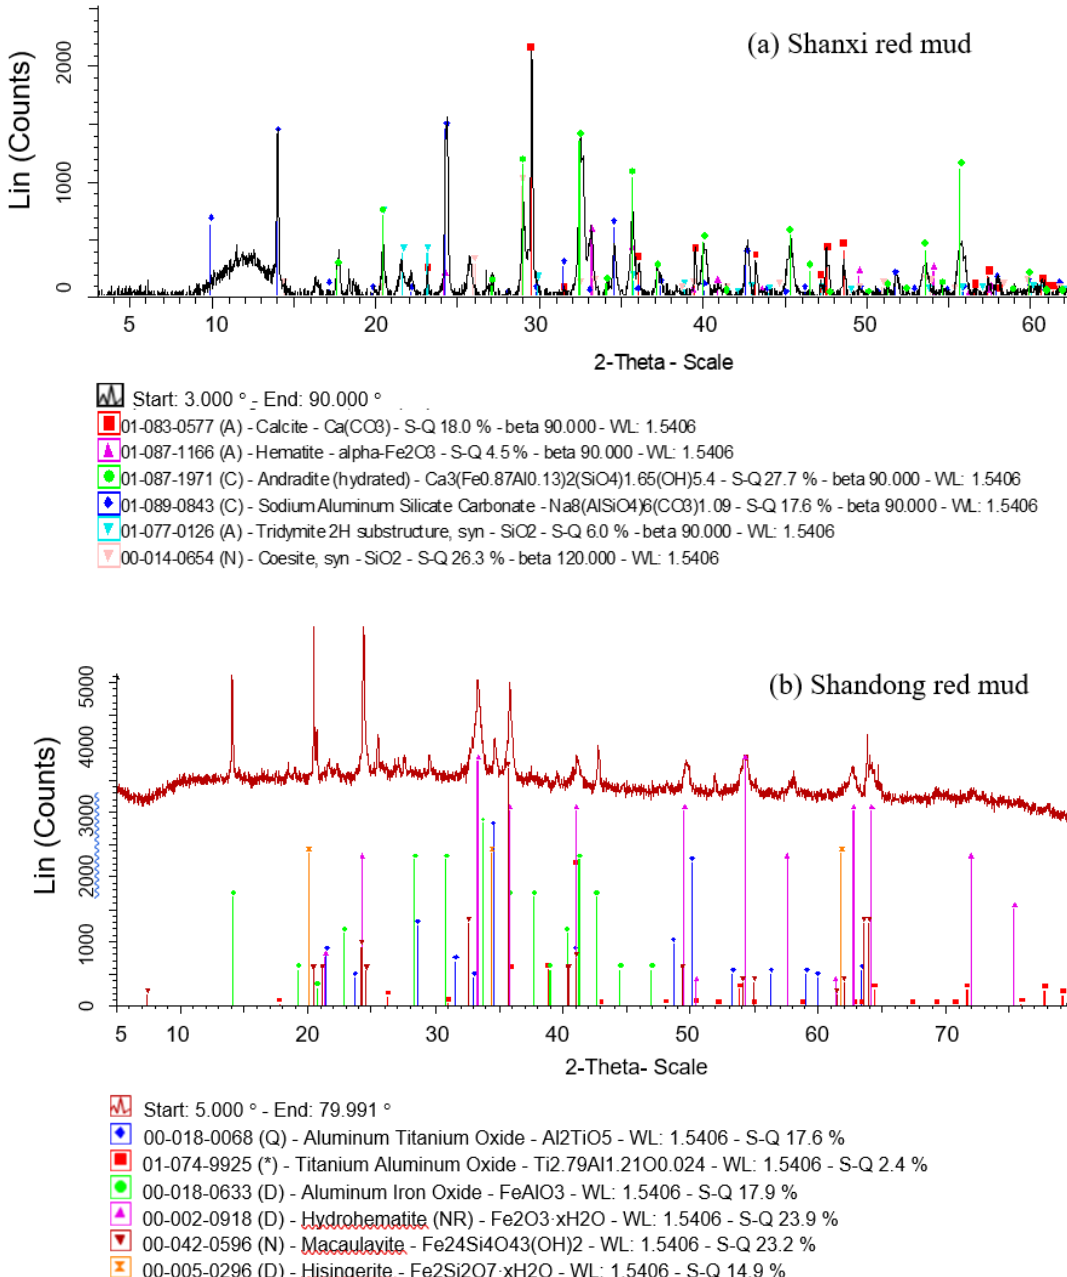
Figure 4. X-ray di ff raction (XRD) patterns of the solid particles—( a ) Shanxi red mud, and ( b ) Shandong Figure 4. X-ray diffraction (XRD) patterns of the solid particles — ( a ) Shanxi red mud, and ( b ) red Shandong red mud.